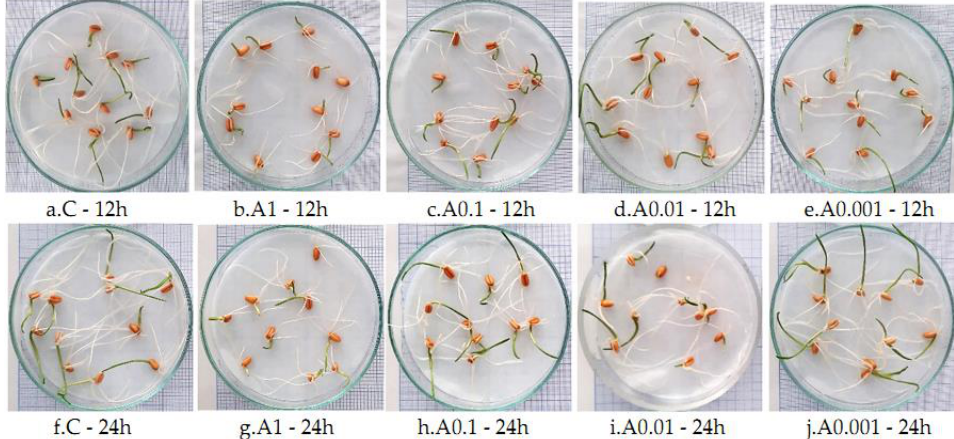
Figure 6. ( a – e ) Triticum aestivum seedlings 5 days after exposure to Actellic 50 EC for 12 h;. ( f – j ) Triticum aestivum seedlings 5 days after exposure to Actellic 50 EC for 24 h.